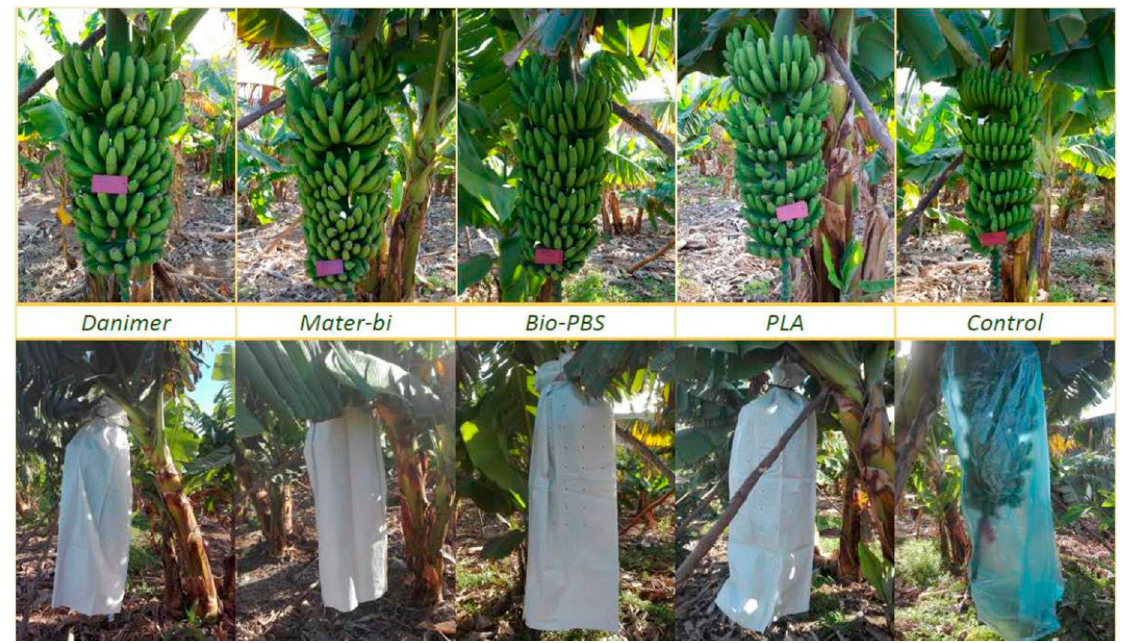
Figure 8. Banana sleeves tests on the plantation (1st generation).